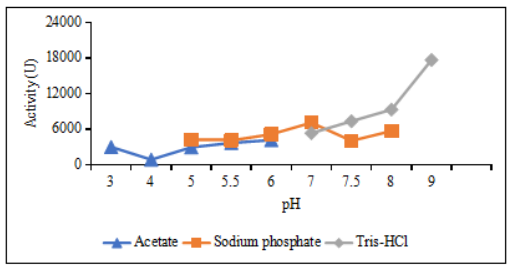
Fig. 3. The pH optimization of AChE activity in expres- sion of mean of triplicates ± standard deviation.